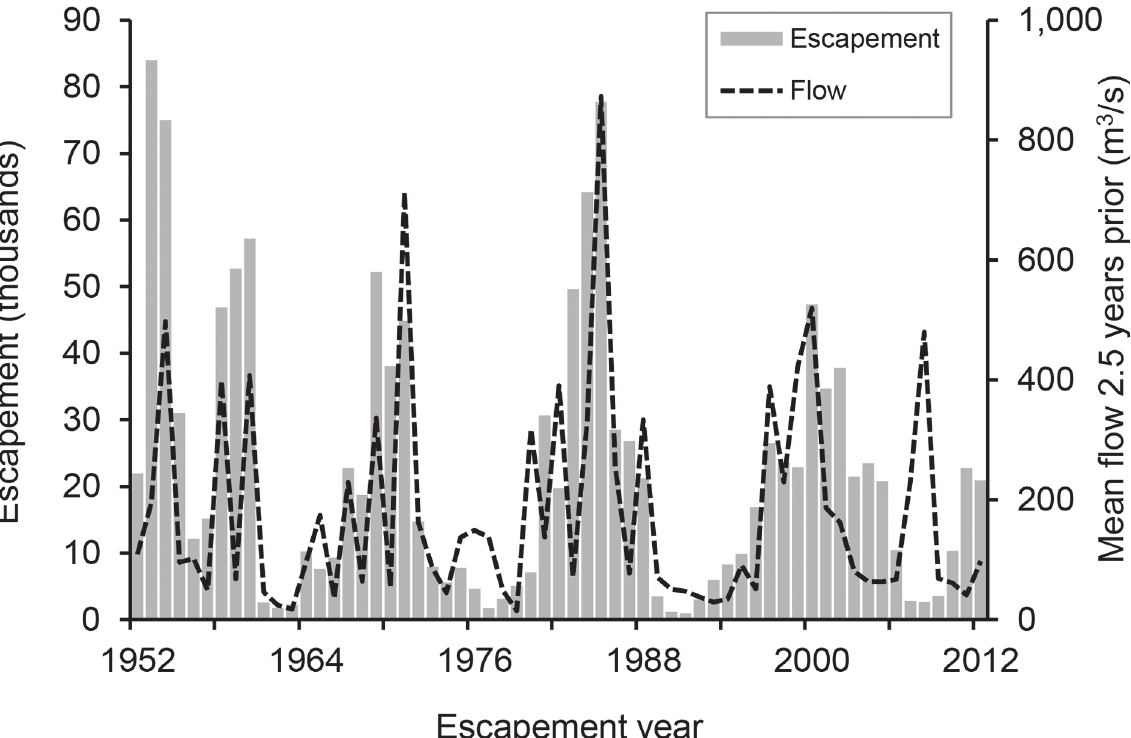
Fig 1. Relationship between adult salmon returns to the San Joaquin basin and the river flows experienced as juveniles. Fall-run Chinook salmon returns ( ‘ escapement ’ ) to the San Joaquin basin from 1952 to 2011 (CDFW GrandTab, www.CalFish.org) relative to mean flows at Vernalis (USGS gauge 11303500, http://waterdata.usgs.gov/nwis) for the January to June outmigration period they experienced 2.5 years previous. Note that adult abundance estimates have not been corrected for age distributions (we assumed that all adults returned at age 3), inter-annual variation in harvest rates or out-of-basin straying. The large deviation in 2007 reflected poor returns that were attributed to poor ocean conditions [96] and resulted in the closure of the fishery. Adapted from [97].